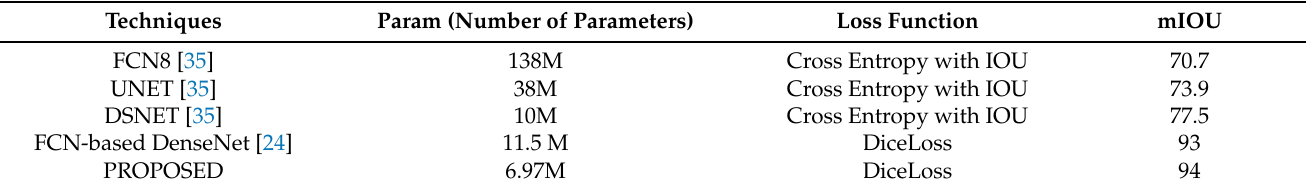
Table 7. Proposed system performance evaluation based on number of parameters, loss function and mIOU on ISBI